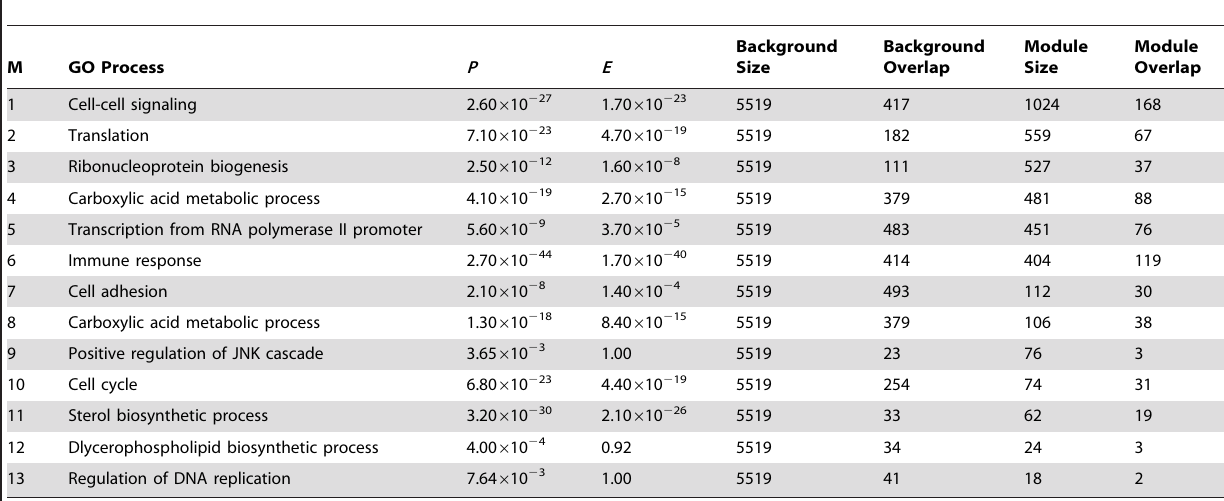
Table 1. Over-represented GO biological process categories for modules identified from the conserved liver co-expression network among human, mouse and rat.